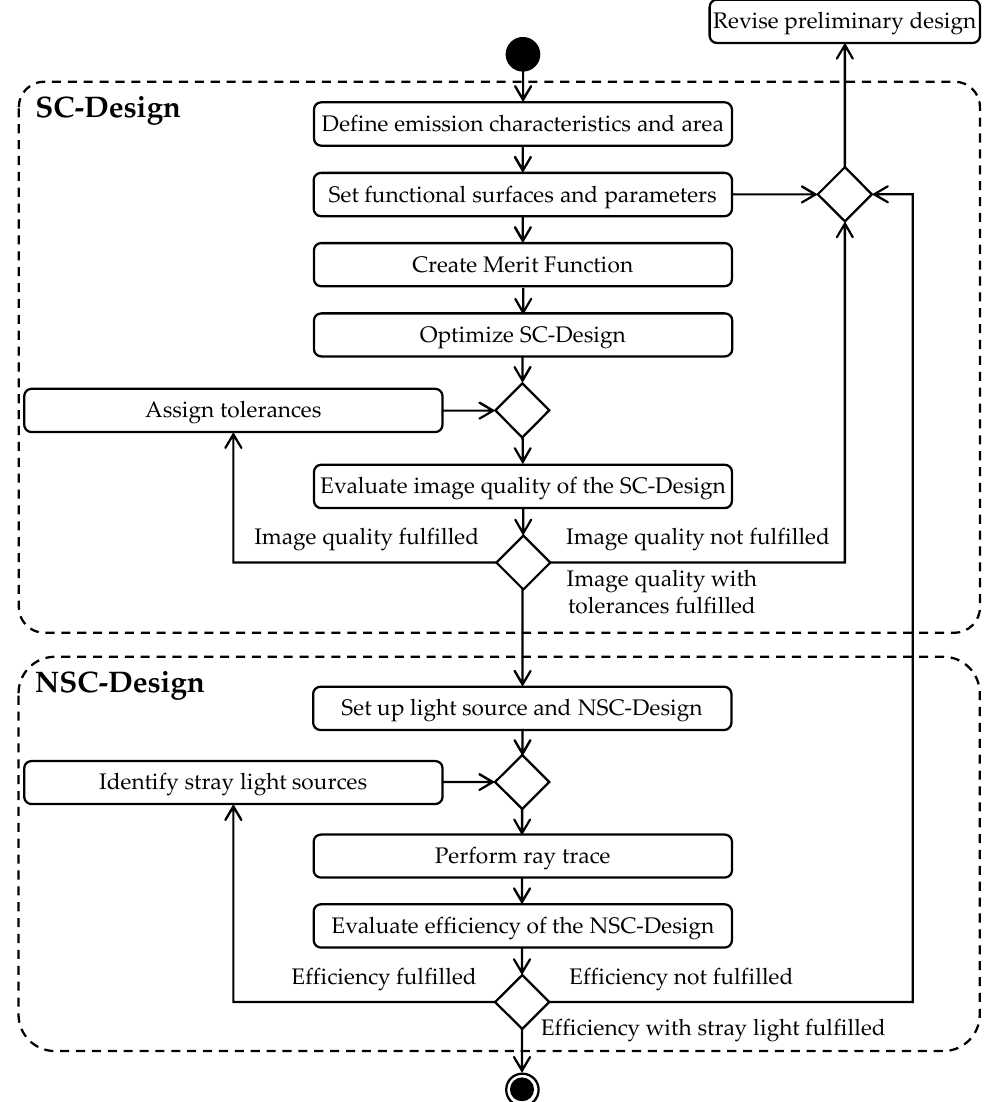
Figure 9. Method for the sequential and non-sequential detailed design of high-resolution lighting systems according to